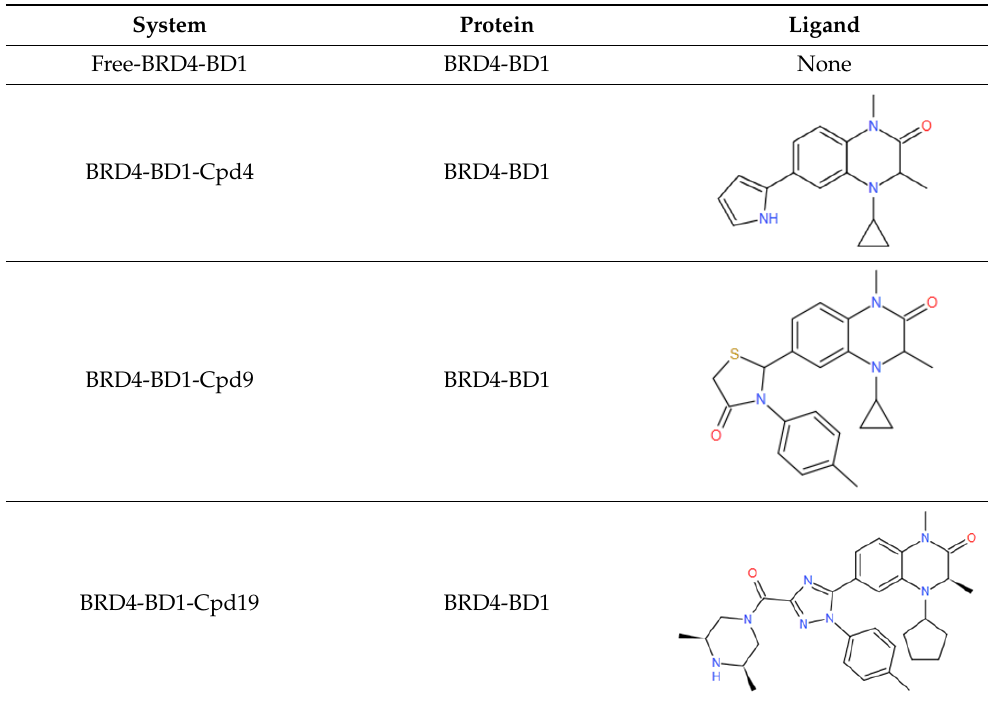
Table 1. Four systems in 150 ns molecular dynamics simulations.